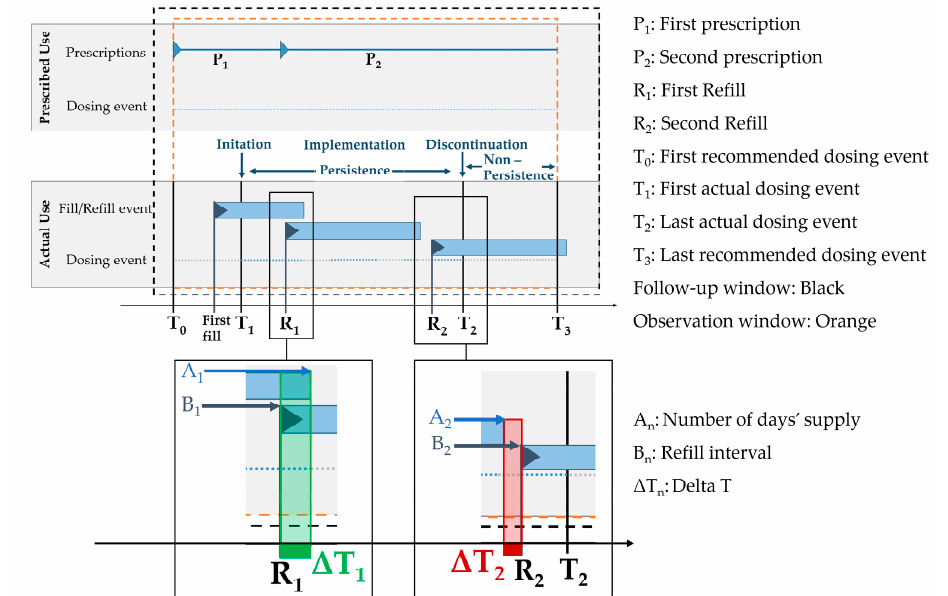
Figure 1. Visualization of a refill history of a fictitious patient with the phases of medication adherence according to the ABC taxonomy [11] (Adapted from Frontiers, 2018), the defined timelines and events according to the TEOS framework adapted from [15], and the characterization of the refill events with ∆ T. Dots represent the dosing history with dosing event (blue) and without dosing event (grey). The backline of the triangles indicates the refill events and must not correspond to the dosing events (T0-T3). Blue bars represent the duration of the